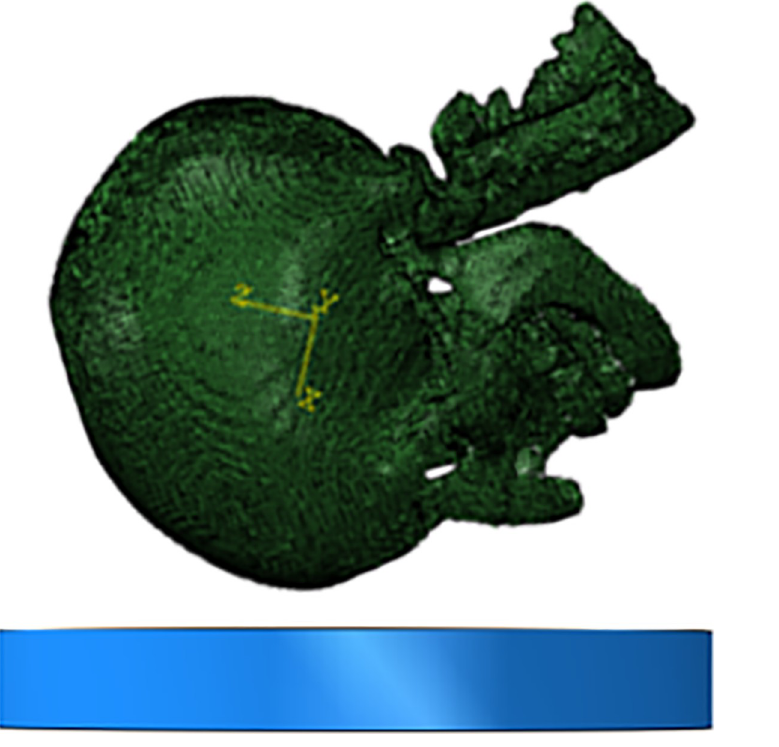
Fig 12. Diagram of frontal landing